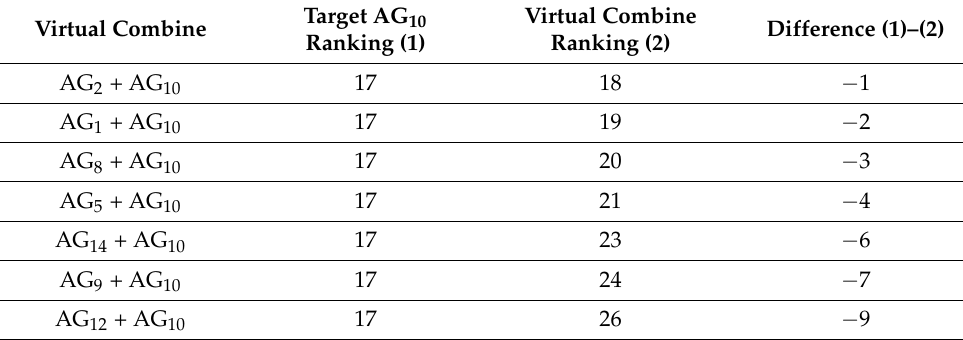
Table 18. The inappropriate